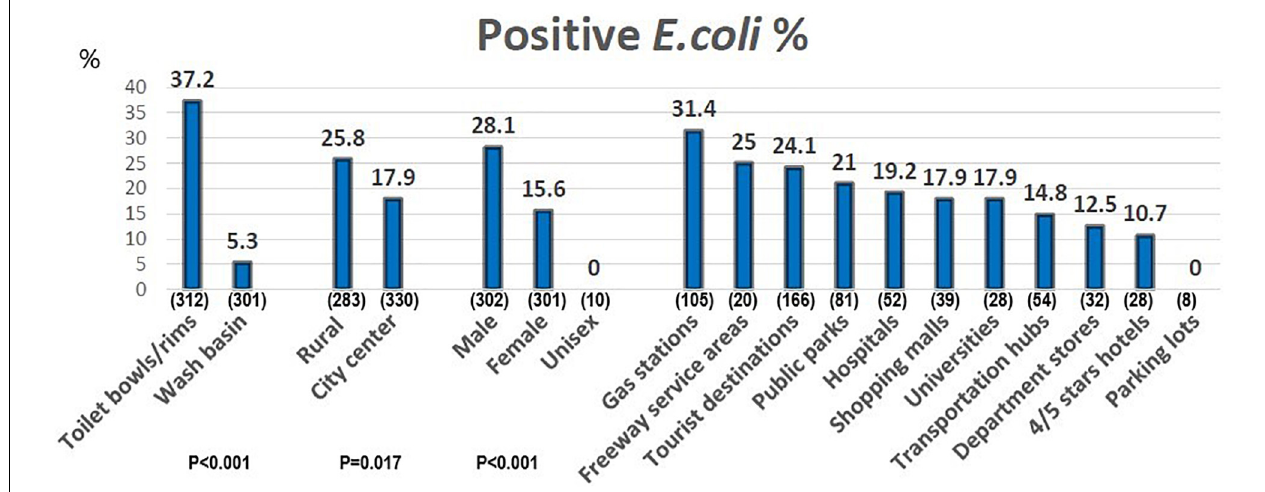
FIGURE 1 | The percentage of positive E. coli in different public restrooms. X -axis: different public restroom, the numbers in parentheses means the sampling numbers. Y -axis: the percentage of positive E. coli.